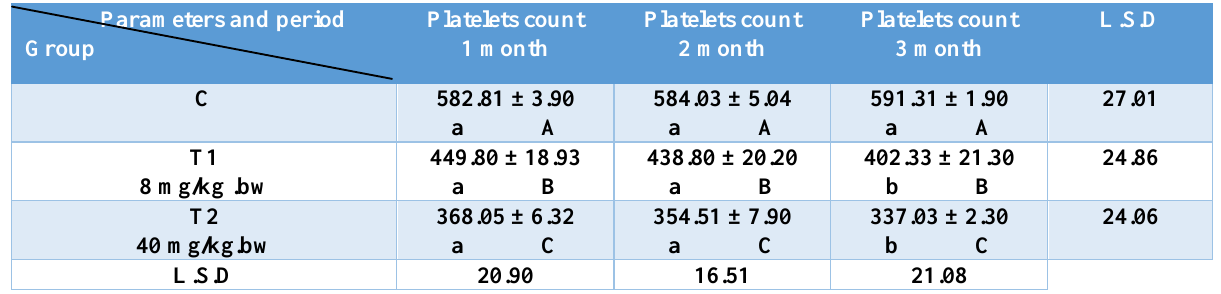
Different small letters means significant (P<0.05) results between